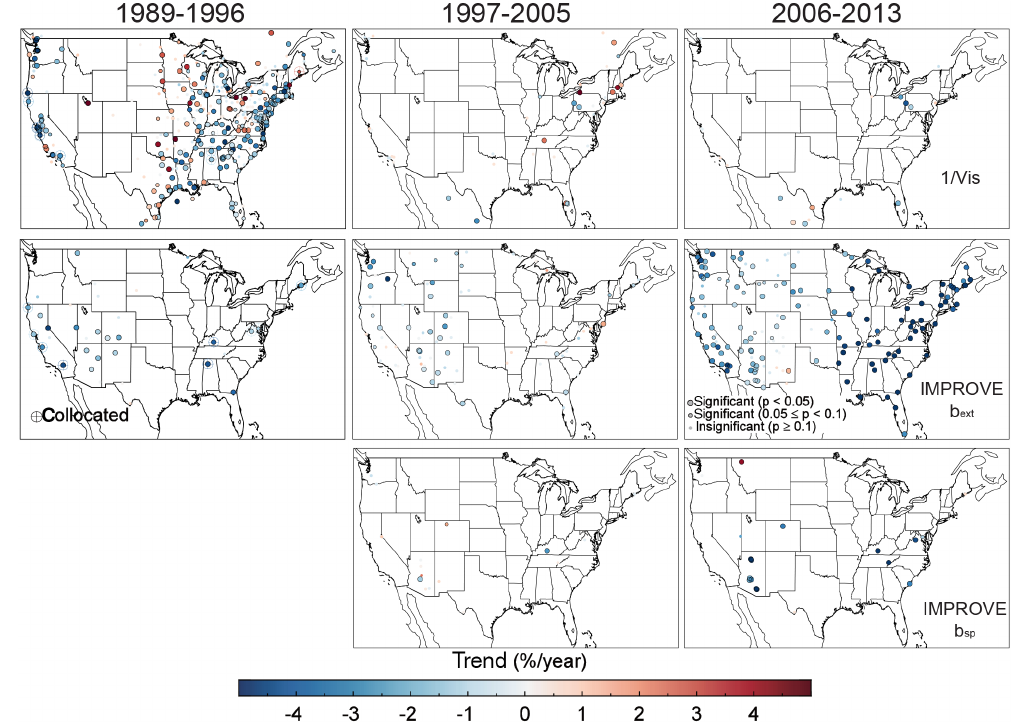
Figure 4. Spatial distribution of relative trends in 1/Vis (top row), IMPROVE b ext (middle row), and IMPROVE b sp (bottom row) over the US for 1989–2013. Larger colored points with black outline indicate trends with at least 95% significance, smaller colored points with black outline represent trends with 90–95% significance, and colored points without outline indicate insignificant trends. Stations with cross and circle symbols are collocated between the ISD and IMPROVE networks over 1989–1996 for composite time series analysis in Fig. 6.